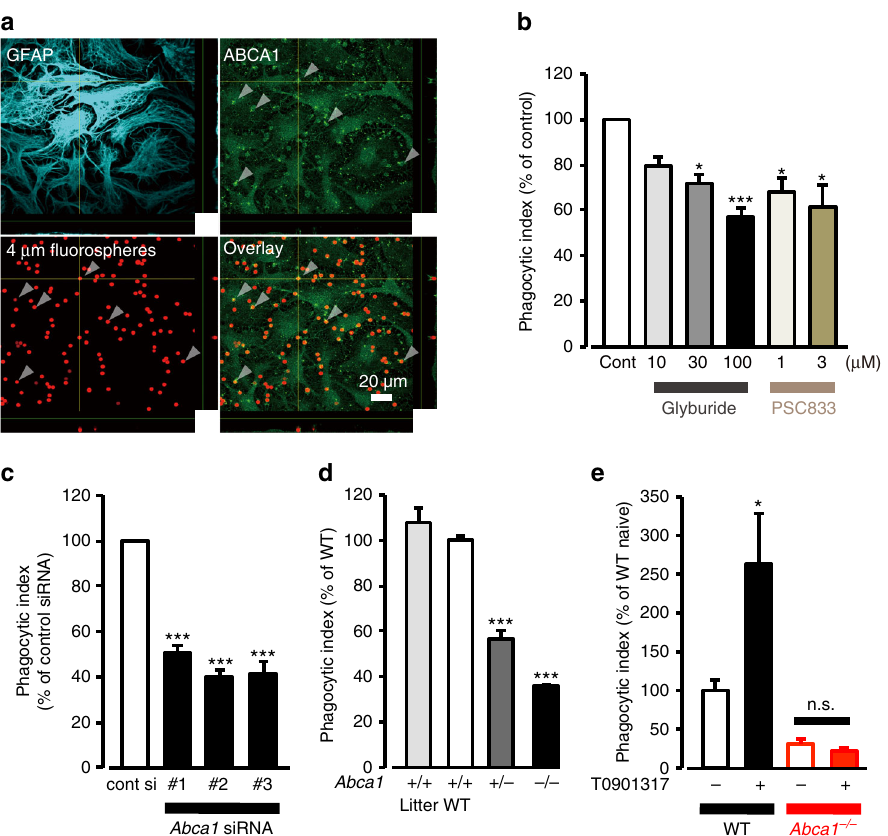
Fig. 7 ABCA1 mediates astrocytic phagocytosis in vitro. a Confocal images show astrocytes (GFAP, cyan ), ABCA1 ( green ), and 4- µ m fl uorospheres ( red ). Astrocytes were incubated with 4- μ m fl uorospheres (30 min after incubation). Arrowheads indicate ABCA1 accumulation and points of attachment between captured beads and astrocytes. Forty-eight images per z-stack images (0.38 µ m step). b Phagocytic activities in the presence of ABCA1 inhibitors. Astrocytes were pretreated Glyburide or PSC833 for 15 min prior to the addition of 4- μ m fl uorospheres, and uptake was assessed by FACS after 1 h ( n = 15, 6, 6, 15, 6, 6, * P < 0.05, *** P < 0.001 vs. control, unpaired t -test). c Phagocytic activities of astrocytes transfected with control siRNA or Abca1 siRNAs ( n = 11, 14, 10, 11, ***P < 0.001 vs. control siRNA, unpaired t -test). d Phagocytic activities of astrocytes from wildtype (WT), Abca1 +/ − , or Abca1 − / − mice ( n = 3, 13, 7, 14, *** P < 0.001 vs. littermate control (Litter), one-way ANOVA (P < 0.0001) with Tukey ’ s multiple comparison test). e Phagocytic activities of astrocytes from WT or Abca1 − / − mice with or without T0901317 pretreatment (100 nM, 48 h) ( n = 11, 13, 7, 8, * P < 0.05 vs.